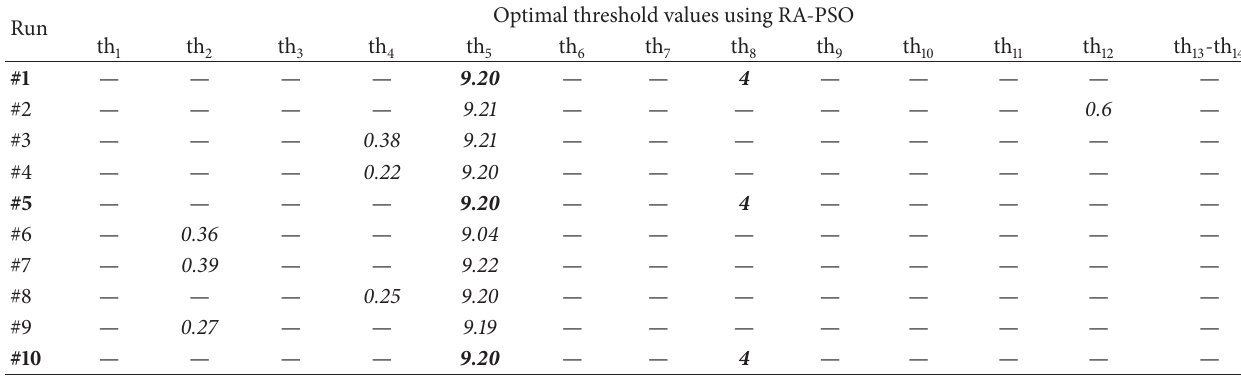
Table 13: Training results: the optimal decision threshold values of 10 runs using RA-PSO.